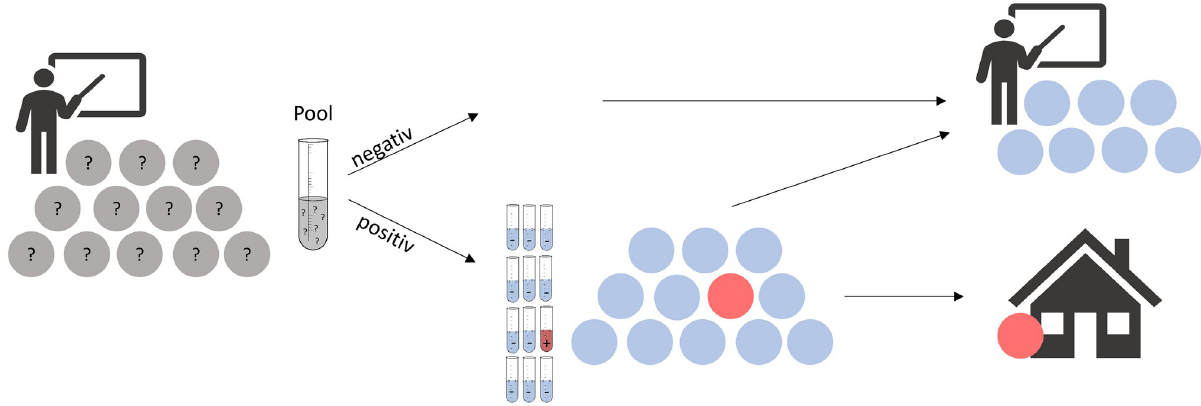
Fig 2. Schematic illustration of the saliva swab pool PCR testing procedure in schools. Here, the blue balls represent the SARS-CoV-2 negative individuals, whereas a red ball represents the positively tested individual(s).